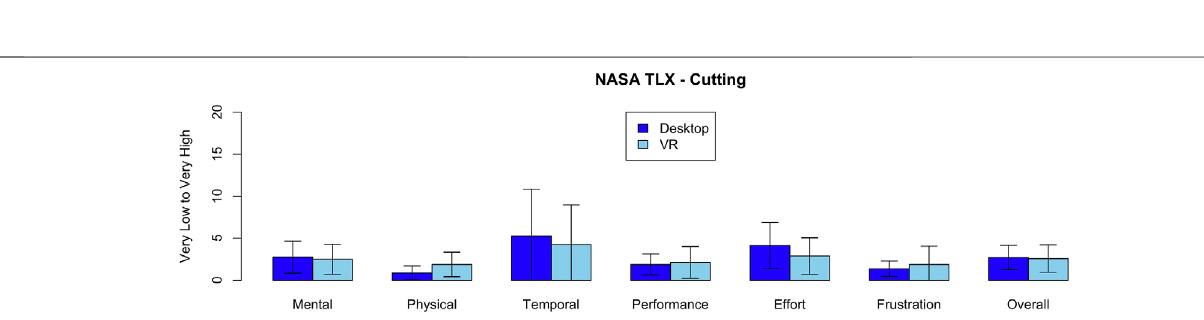
FIGURE 9 | Task 2: TLX values for the cutting task comparing the Desktop and the VR condition.